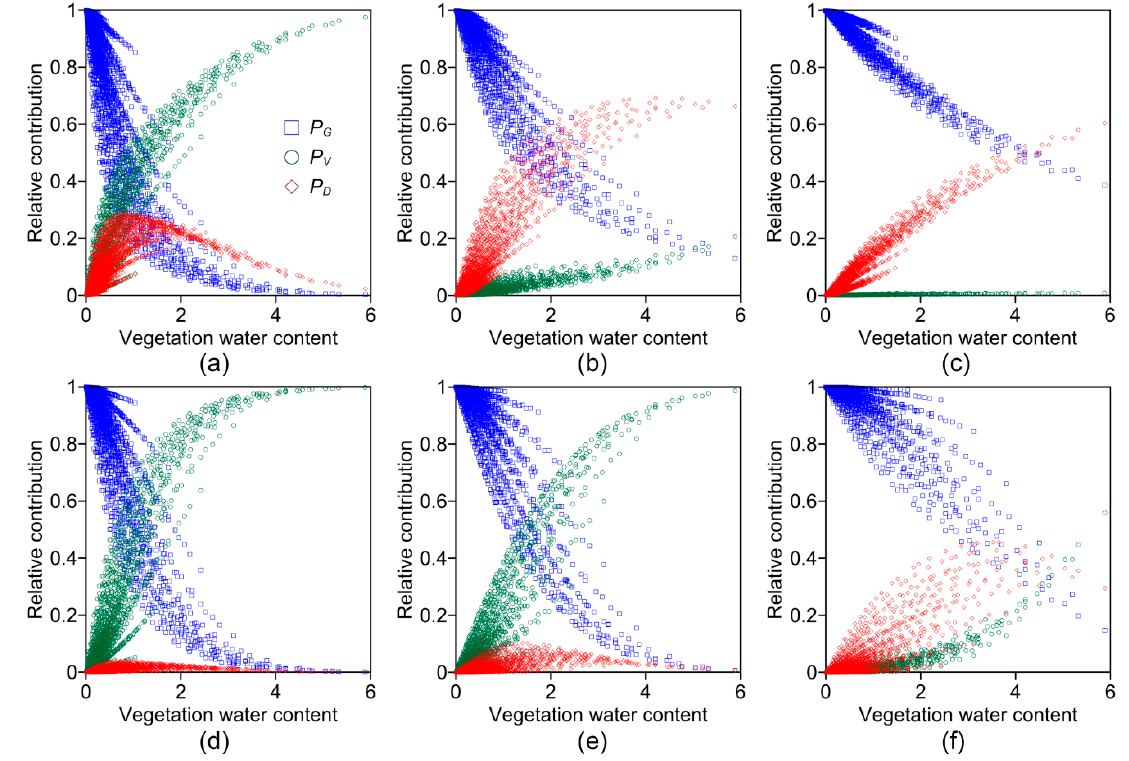
Figure 12. Variations of the relative contribution of each scattering mechanism at ( a – c ) HH- and ( d – f ) VV-polarizations. Figures in the left, center, and right correspond to the results obtained for uniform, medium, and vertical distribution of the particle orientation angle, respectively.